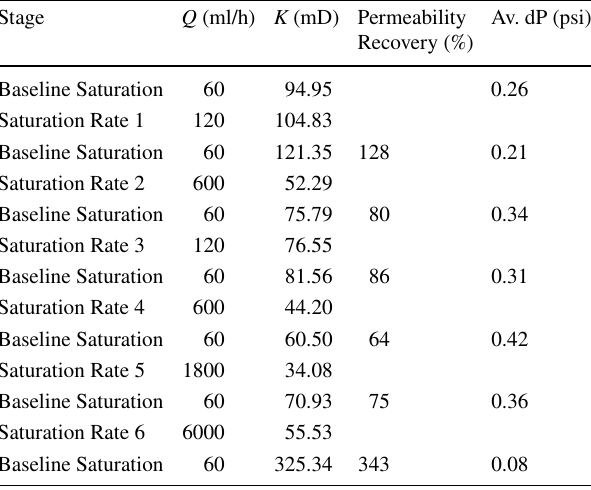
Table 11 Permeability and baseline differential pressures for core flood 4, temperature held constant at 136 °C